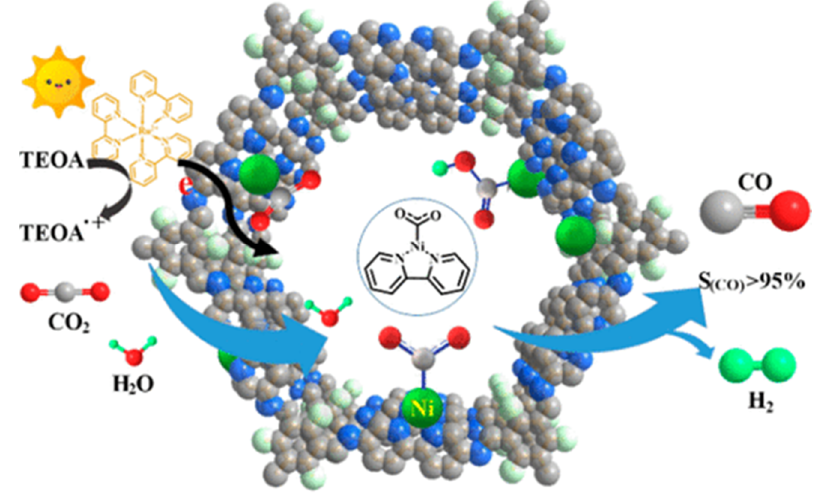
Figure 3. Schematic diagram of photocatalytic selective reduction of CO 2 over Ni-TpBpy. Copied with permission from ACS 2019